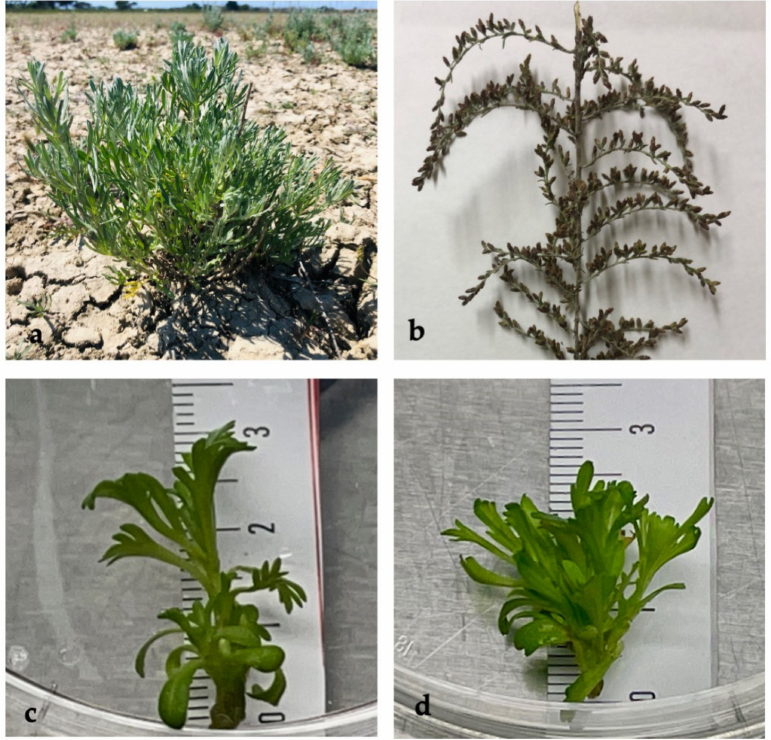
Figure 1. ( a ) Artemisia caerulescens in its natural habitat in the San Rossore estate (photo by Laura Pistelli); ( b ) ripe inflorescence ( c ) 4-week-old shoots in MSO medium; ( d ) 4-week-old shoots in 4 µ M MS-BA